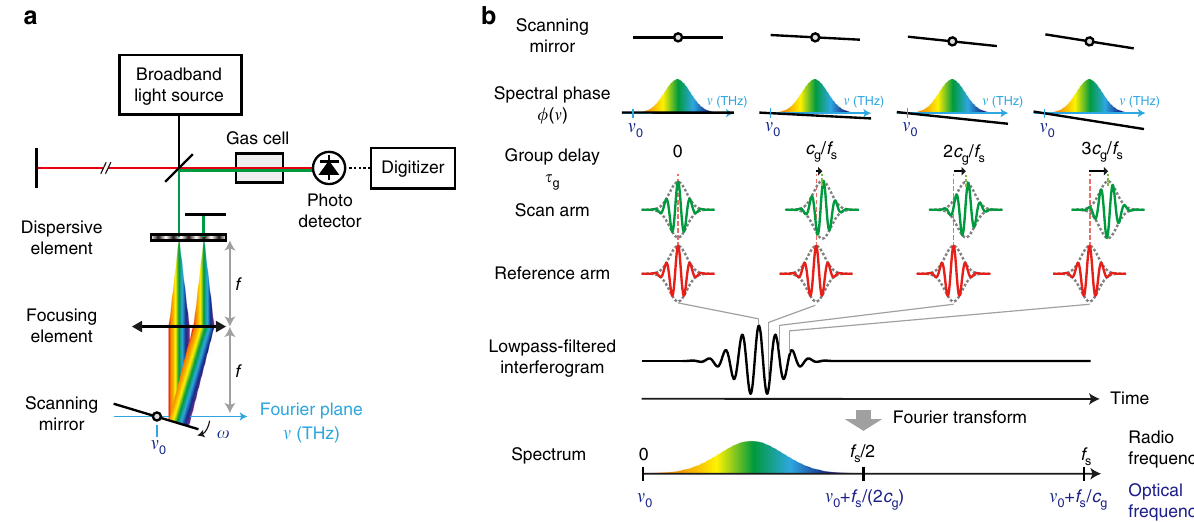
Fig. 1 Schematic and conceptual illustration of phase-controlled Fourier-transform spectrometer. a Schematic of the system. The system consists of a broadband light source, a scanning Michelson interferometer with the rapid-scan phase-controlled delay line, a sample gas cell, a photodetector, and a digitizer. The delay line consists of a dispersive element, a focusing element, and a scanning mirror aligned in a re fl ective 4f-con fi gulation. The broadband light is focused at the Fourier plane in the 4f system after spectral separation by the dispersive element such that each spectral component is mapped on a different position at the Fourier plane. The scanning mirror changes its angle at an angular frequency of ω and re fl ects the light with angled directions. The beam traveling through the 4f system is retro-re fl ected with an end mirror and goes back along the same path. The corresponding optical frequency of the pivot position of the scanning mirror in the Fourier plane is indicated as ν 0 . b Concept of PC-FTS. The upper part shows how the interferogram is obtained in the time domain. For simplicity, the light fi elds are depicted as a pulse train with zero carrier-envelope-phase as shown in the pulses in the reference arm. Here, f s denotes the sampling rate, which may be determined by the pulse repetition rate or sampling rate of the digitizer. At each time frame, the light fi eld in the scan arm acquires a linear spectral phase that is proportional to the angle of the scanning mirror in the delay line. The linear spectral phase ramp adds a group delay and phase delay to the light fi eld. The pivot frequency ν 0 is converted to the zero frequency in the down-converted RF spectrum after Fourier-transformation. Therefore, the down-converted spectrum can be positioned inside of the Nyquist range (0 − f s /2) by adjusting ν 0